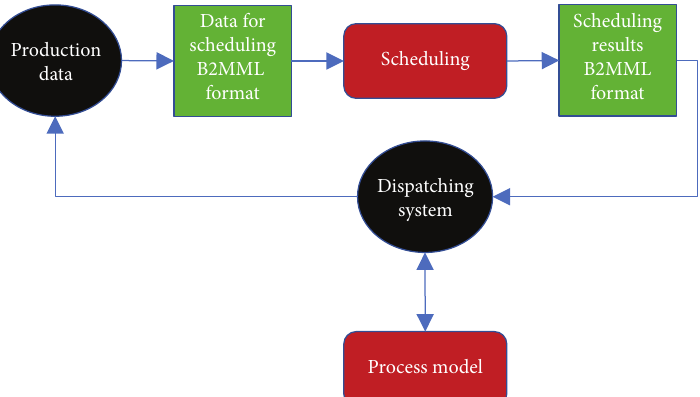
Figure 10: The workflow using B2MML for scheduling.